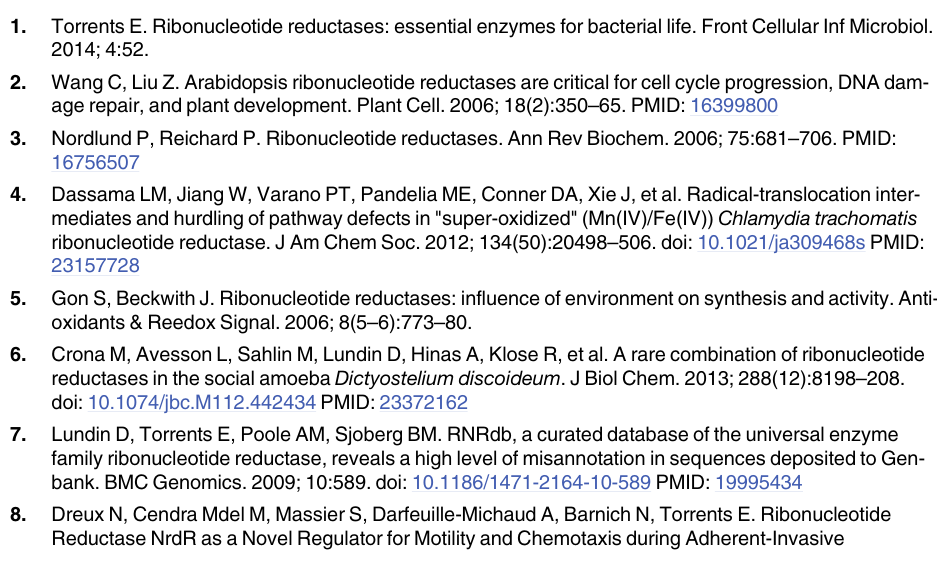
average fluorescence of host cell adhered WT, Δ NrdR and OE_NrdR E . coli form the four inde- pendent repeats samples were quantified from the ImageJ software and student t -test was per- formed to shows statistical significance p = 7.67 E -07 . S1 Table. Global proteome analysis of NrdR-deletion and NrdR-overexpression strains compared with the wild-type E . coli strain. The summarized results are tabulated in the order of serial number, UniProt accession number, protein name, description of the protein, n-fold -fold change in expression ( Δ NrdR and NrdR-overexpression) change in expression and log 2 compared to WT E . coli . Genes are listed